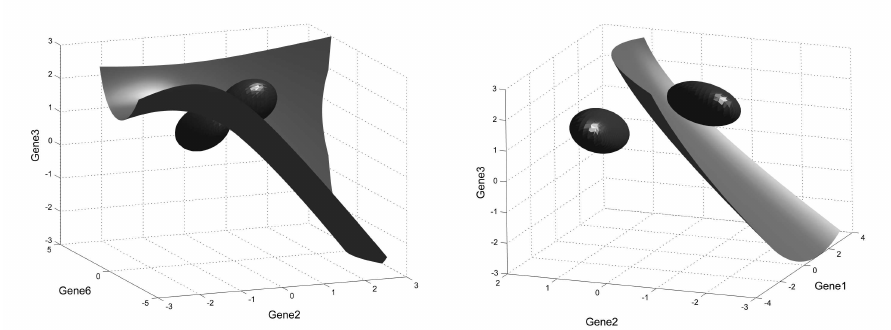
Figure 1. Ellipsoids of estimated a posteriori probabilities with quadric classification boundary equalizing generalized distances (6) from population centroids, for variables x 2 , x 6 , x 3 (left) and x 1 , x 2 , x 3 (right); apparent errors = 0.105, CV = 0.12 (SD =